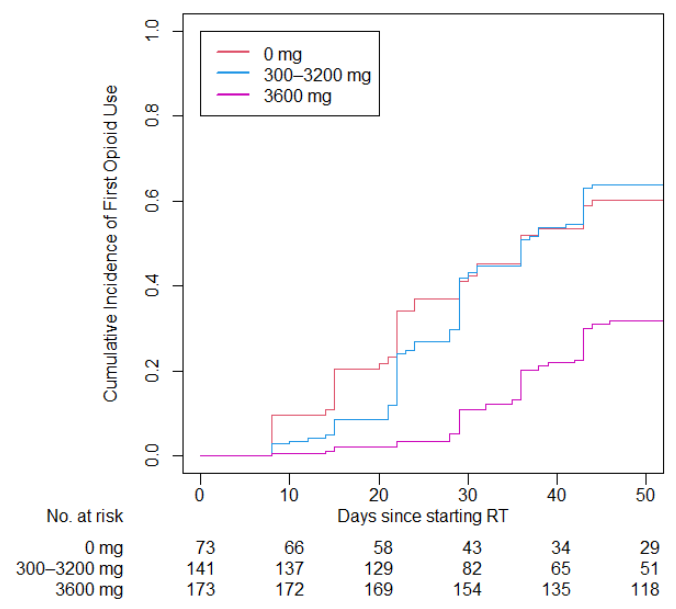
Figure 1. Cumulative incidence of fi rst opioid use during RT over time.